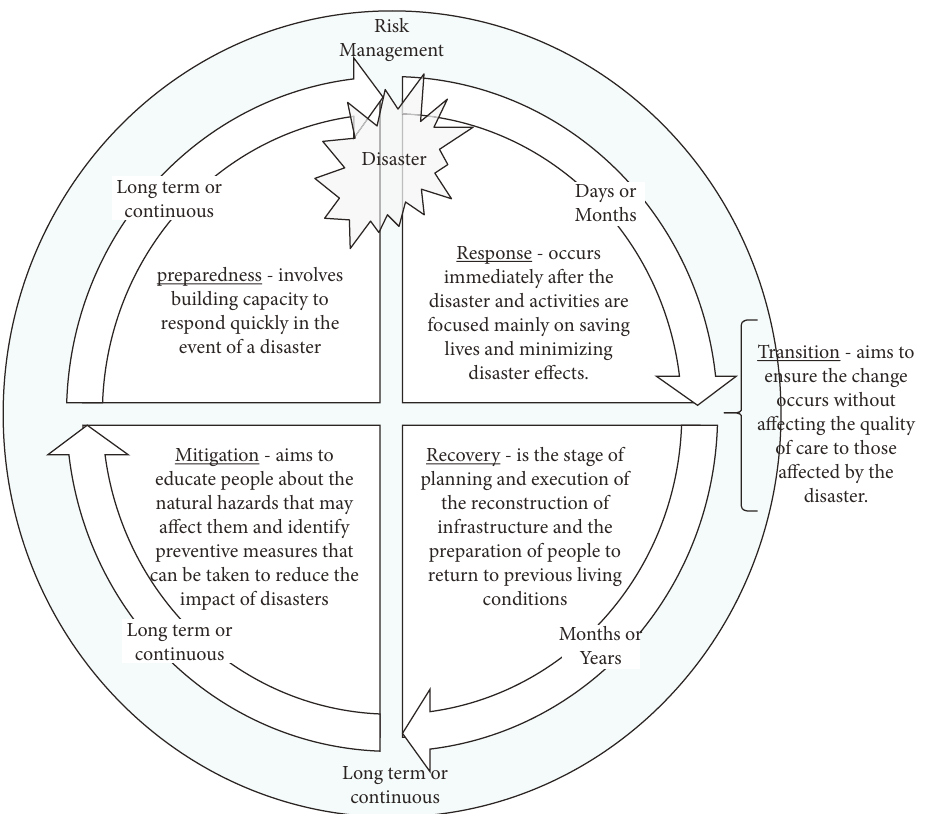
Figure 1: A model integrating risk management in the DMC used in this study (based on